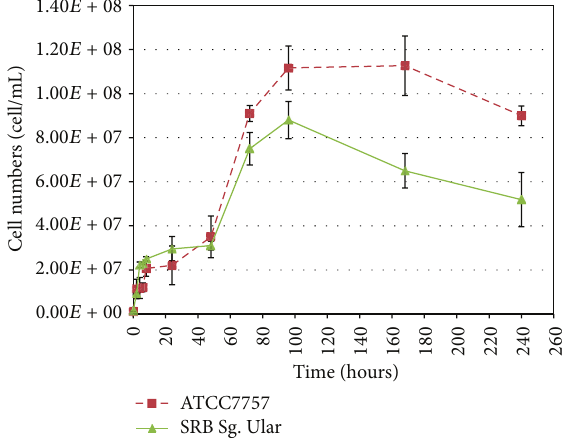
Figure 3: SRB growth curves for ATCC and Sg. Ular SRB strain for 240 hours at 37 ∘ C.